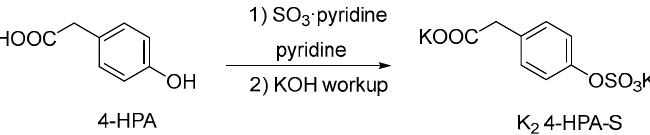
Table 1. Chemical sulfation by SO 3 ·pyridine in pyridine.